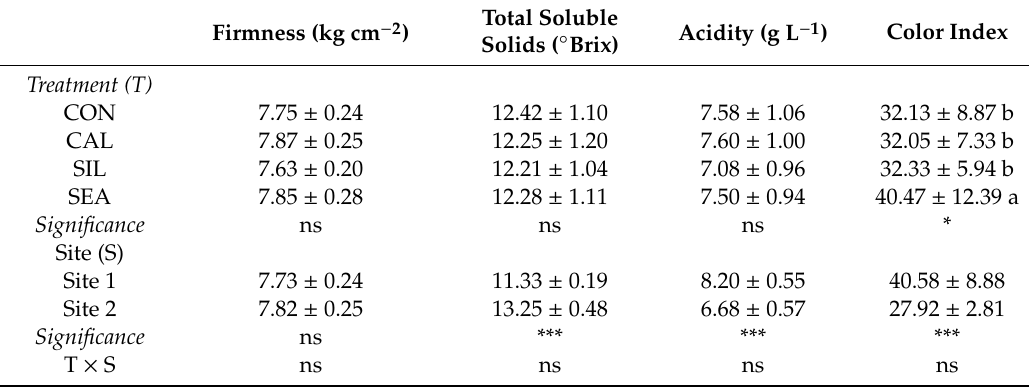
Table 3. Fruit quality traits (firmness, soluble solids, acidity, and color index) as a ff ected by biostimulants and sites 1